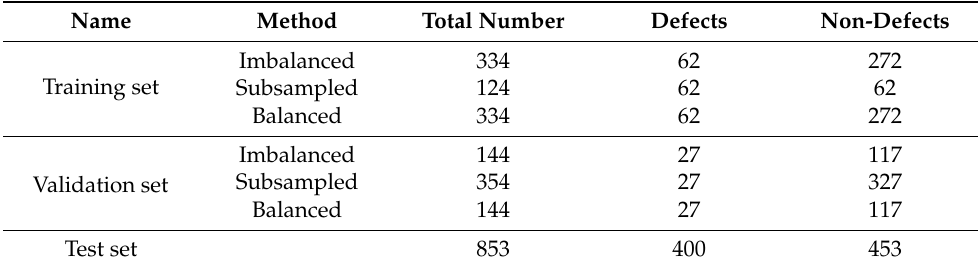
Table 2. Ceramic substrate defect and nondefect data